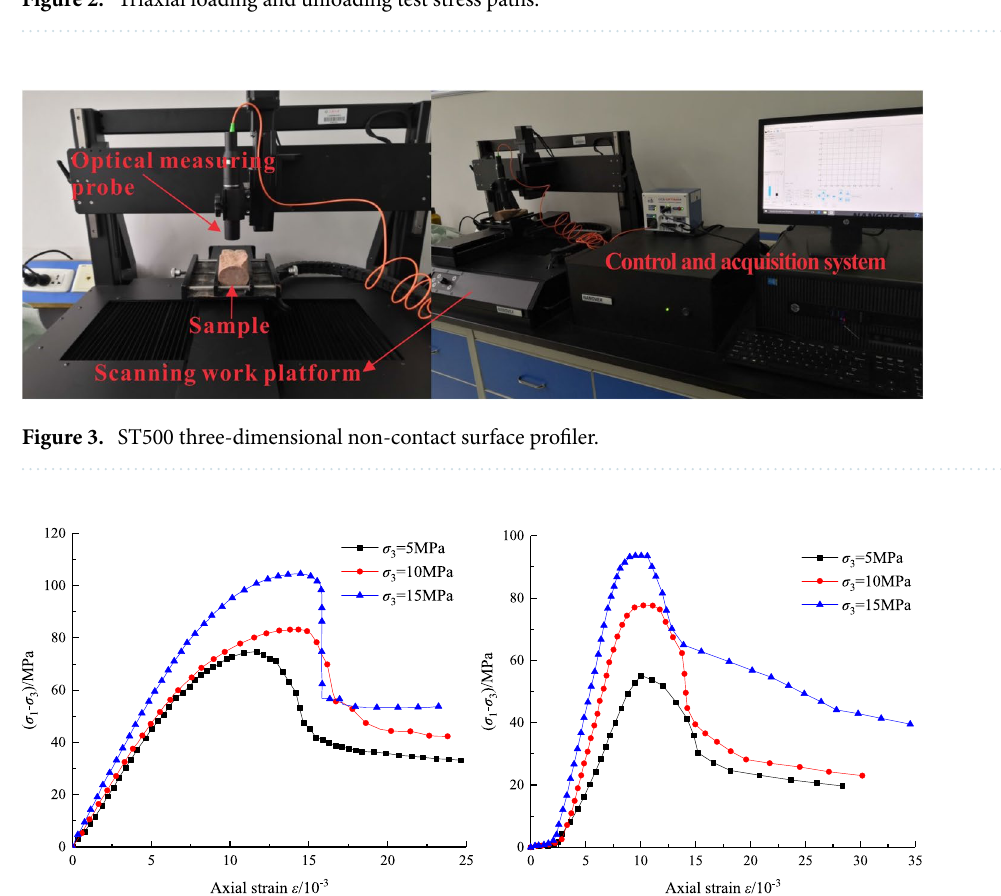
Figure 2. Triaxial loading and unloading test stress paths.